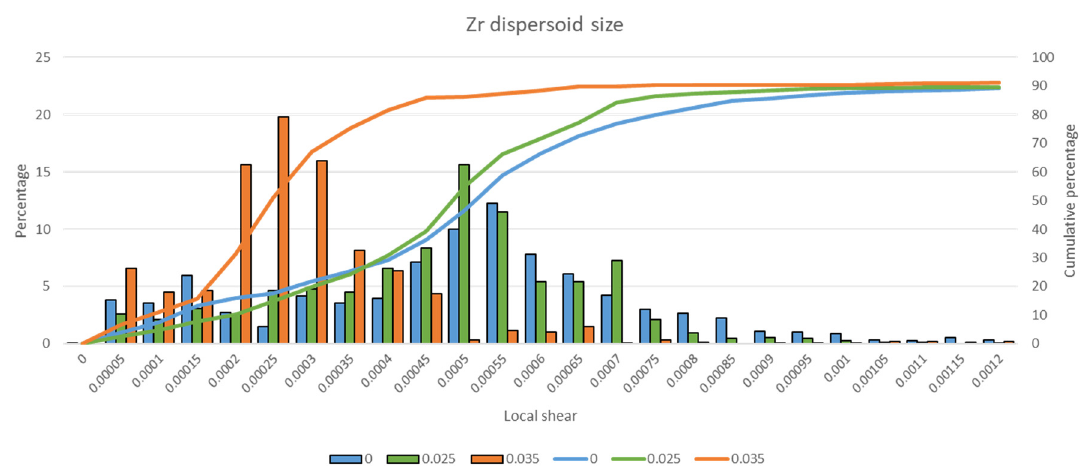
Figure 7. Local shear distribution from DDD simulations showing the isolated effect of Zr dispersoid size (fv = 0.003%). Radii are in µm. Label 0 refers to a simulation without any particle.